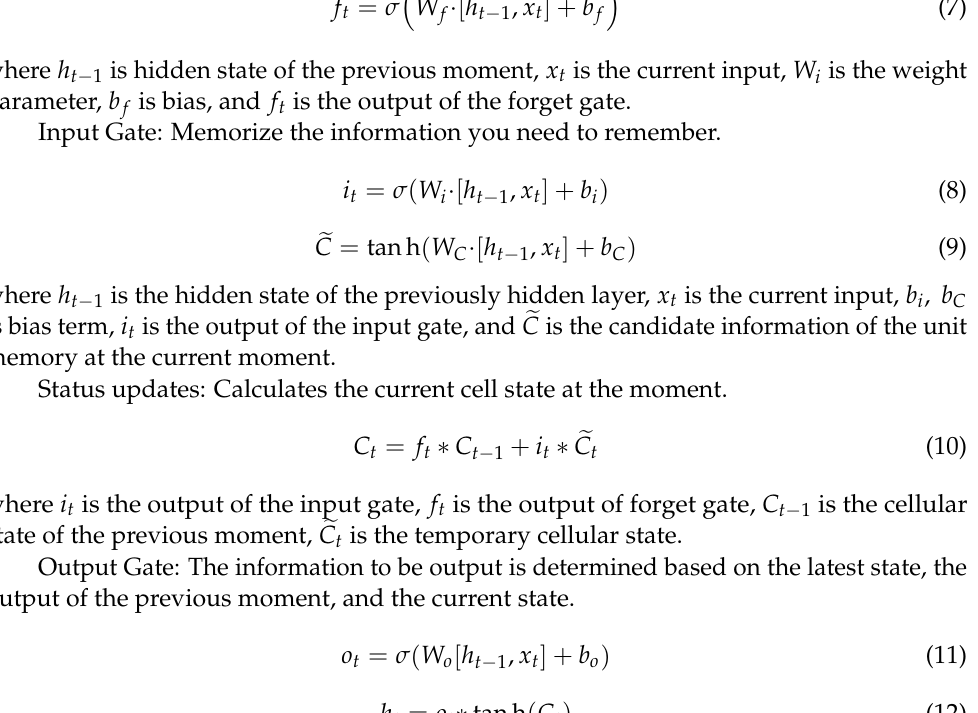
Figure 6. Unit composition of the LSTM block.